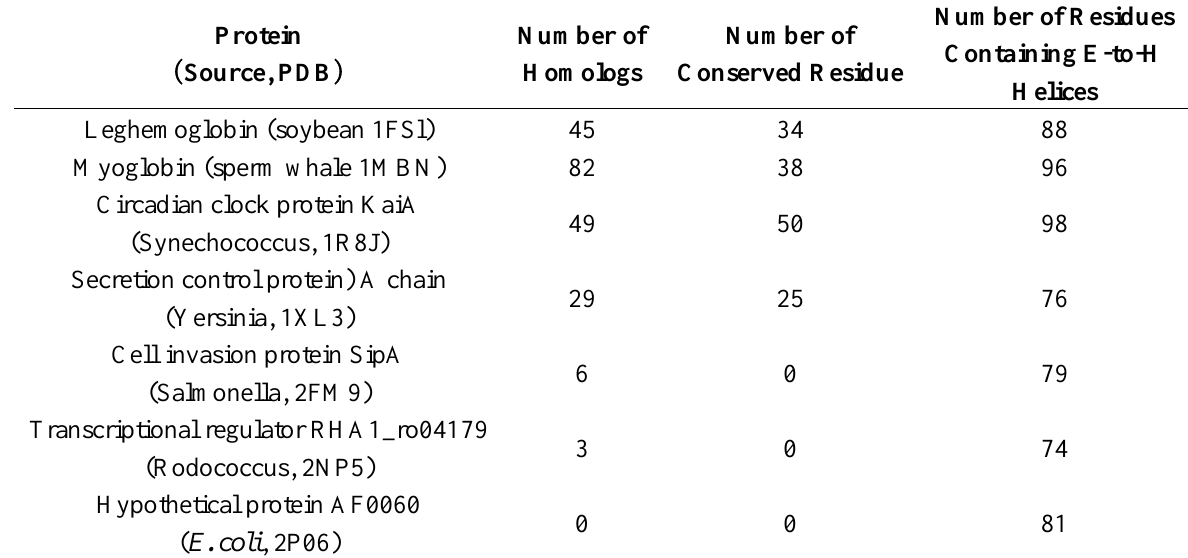
Table 3. Homologues of the proteins in the present analyses.